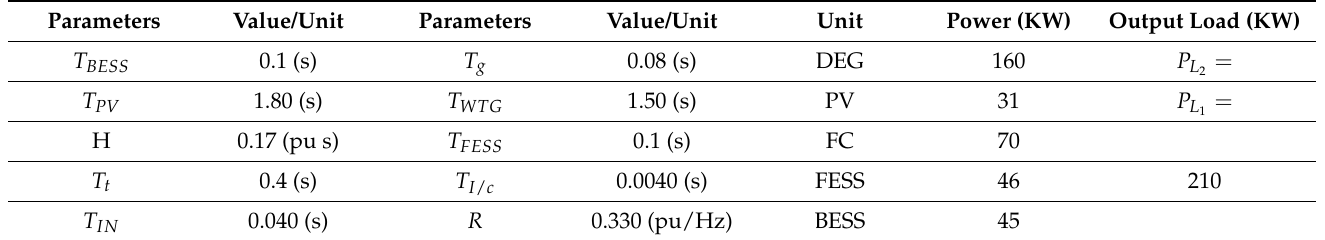
Table 1. System parameter description.